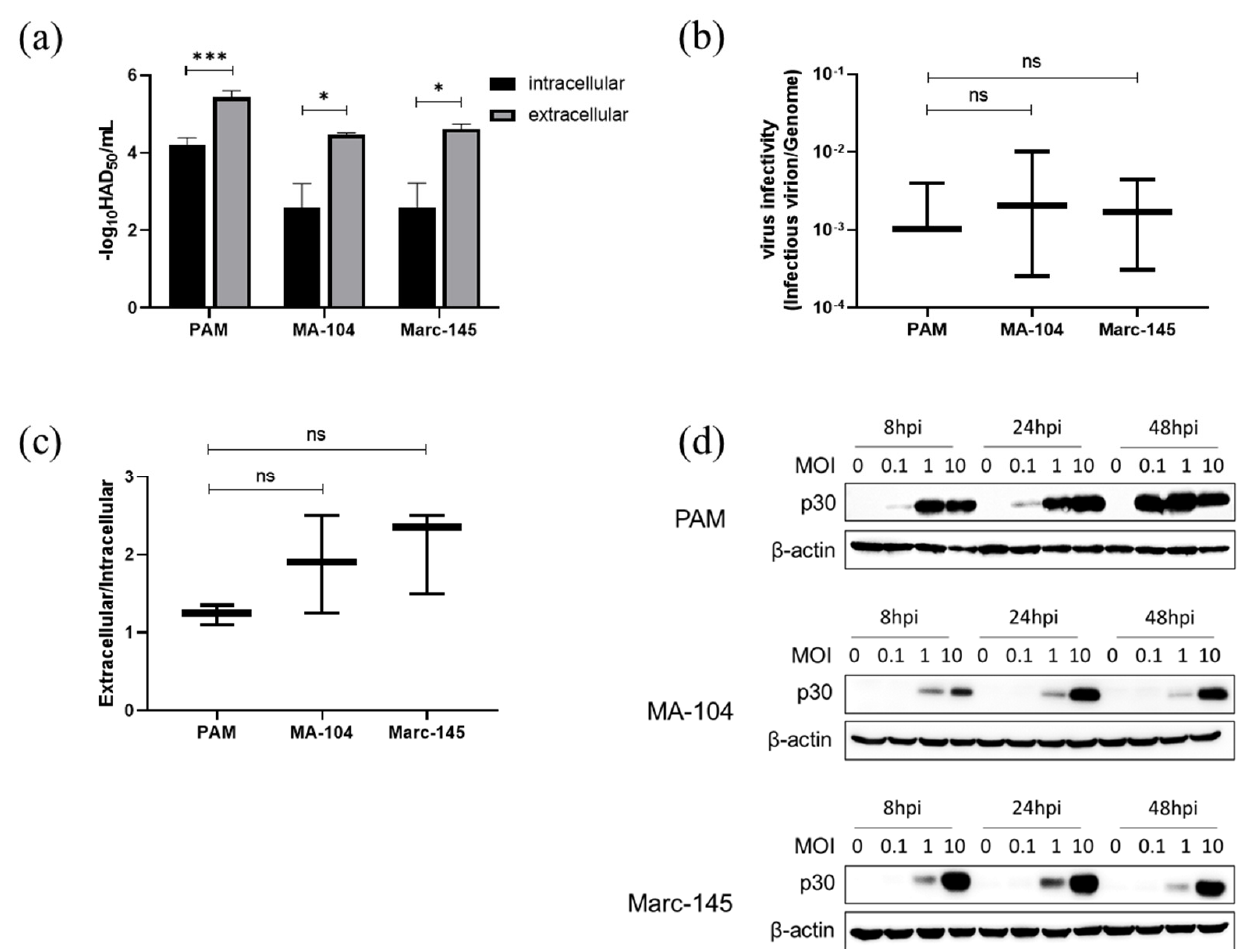
Figure 7. ASFV assembly and release in PAMs, MA-104 and Marc-145 cells. Cells were infected with 5 MOI ASFV for 2 h at 37 °C and washed three times with PBS and incubated with fresh medium for 48 h. The cell supernatant and cells were collected, respectively, for virus titration and genomic DNA quantification. ( a ) Intra- and extracellular virus titers in PAMs, MA-104 and Marc-145 cells. ( b ) Graphical representation of the ratio of infectivity to genomic DNA. ( c ) Graphical representation of the ratio of extracellular to intracellular virus titres. ( d ) The viral p30 protein in cells infected with ASFV at different MOIs was detected with western blot at the indicated 3 time points. ns: no significant difference by t -test. *, p < 0.05; ***, p < 0.005.